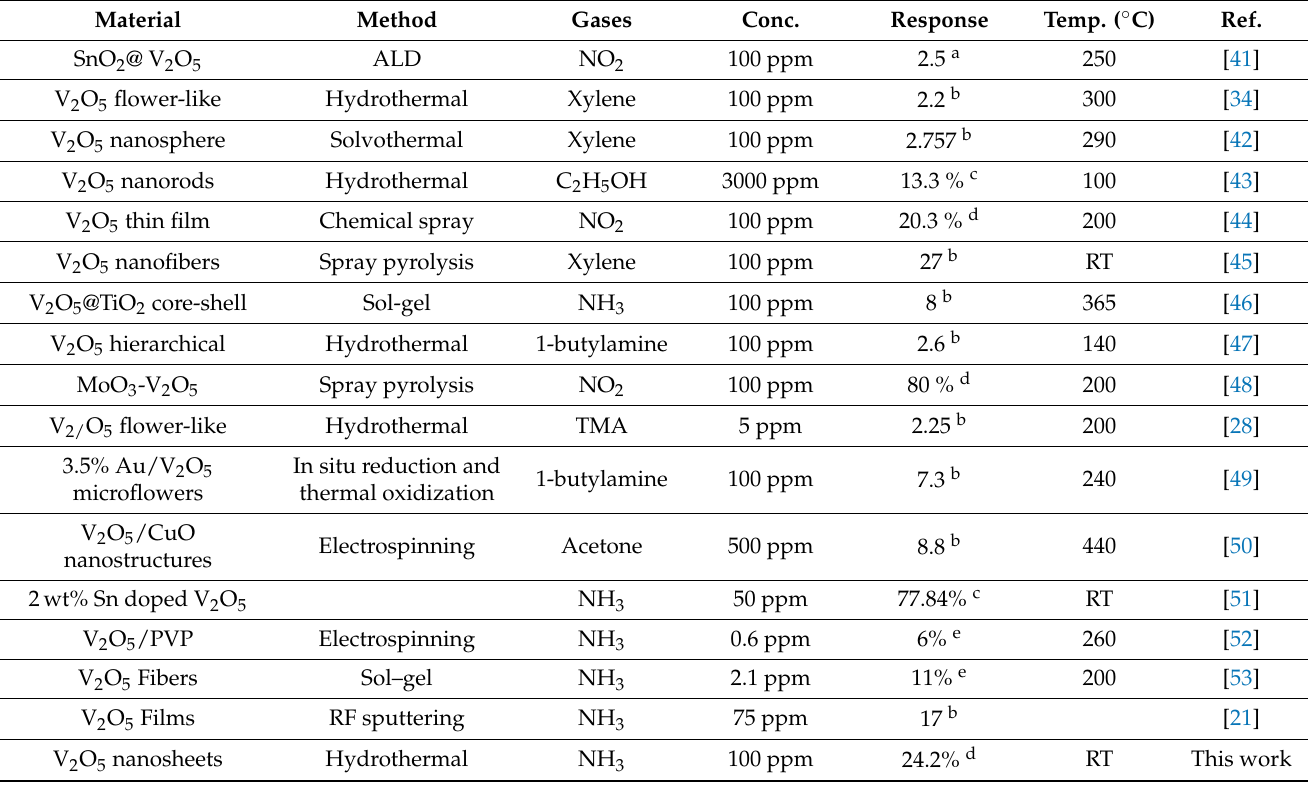
Table 1. Performance comparison of V 2 O 5 nanostructures as gas sensors in recent scientific literature.